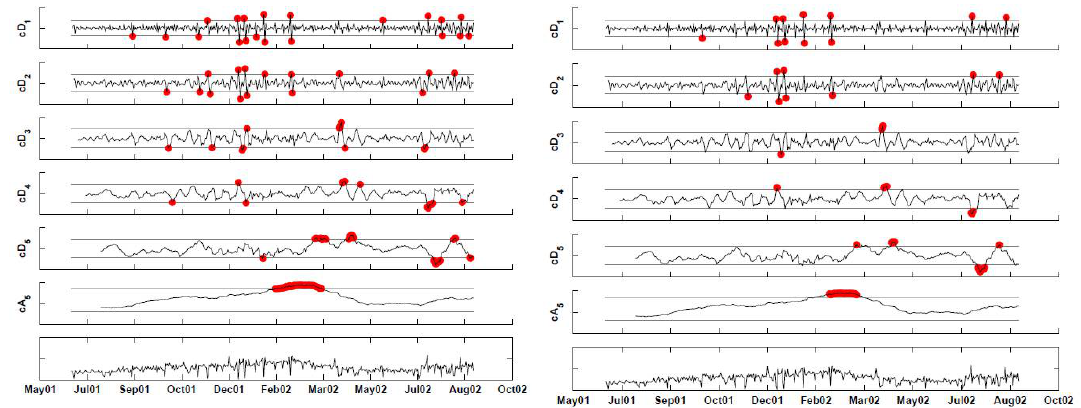
Figure 13. Backward-implemented stationary discrete wavelet transform (SWT) with 3- sigma x-bar charts applied at each scale. The left panel shows alarms based on coefficients that exceed the thresholds. The right panel shows alarms after correcting for multiple